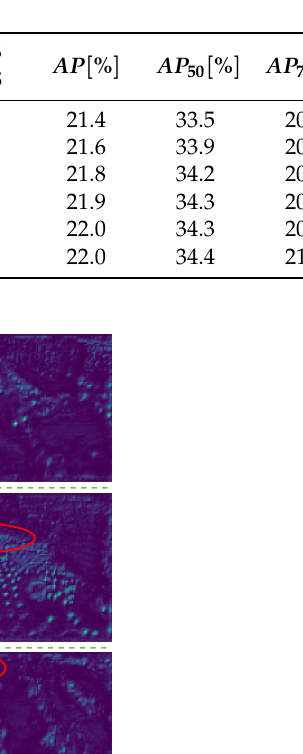
Table 4. Ablation study of GLCC.